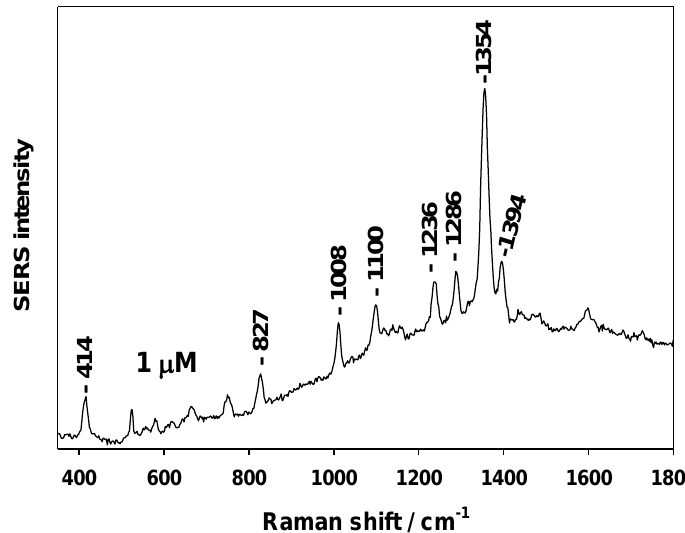
Figure 7. SERS spectrum of fungicide 1-methyl-1H-benzimidazole-2-thiol (1 µ M soaking concentration).